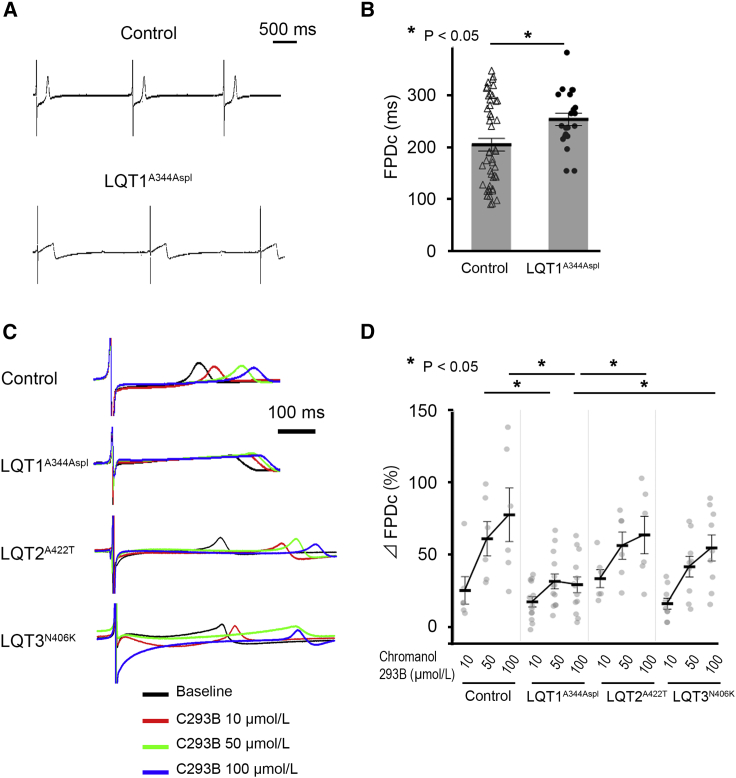
Functional Analysis of iPSC-CMs Using MEA Following IKs Blockade(A) Representative traces of FP in Control- and LQT1A344Aspl-iPSC-CMs.(B) FPDc at baseline was longer in LQT1A344Aspl-iPSC-CMs than in Control-iPSC-CMs (independent experiments, n = 45 and 21 from independent differentiation experiments, n = 16 and 6 in Control- and LQT1A344Aspl-iPSC-CMs, respectively; mean ± SEM; p < 0.05; unpaired Student's t test). ∗p < 0.05.(C) Representative traces of the FPD following administration of 10 μmol/L (red), 50 μmol/L (green), and 100 μmol/L (blue) chromanol 293B in Control- and LQT1A344Aspl-iPSC-CMs.(D) Averaged %ΔFPDc in each cell line. %ΔFPDc upon treatment with 100 μmol/L chromanol 293B was significantly smaller in LQT1A344Aspl-iPSC-CMs than in Control-, LQT2A422T-, and LQT3N406K-iPSC-CMs (independent experiments, n = 6, 13, 6, and 9 from independent differentiation experiments, n = 3, 5, 3, and 3 in Control-, LQT1A344Aspl-, LQT2A422T-, and LQT3N406K-iPSC-CMs, respectively; mean ± SEM; p = 0.001; two-way repeated measures ANOVA). ∗p < 0.05; Fisher's LSD post hoc test.